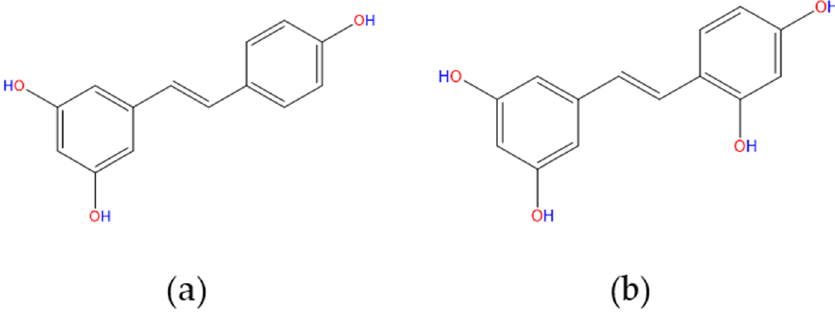
Figure 1. Structure of ( a ) resveratrol and ( b ) Figure 1 . Structure of ( a ) resveratrol and ( b ) oxyresveratrol.